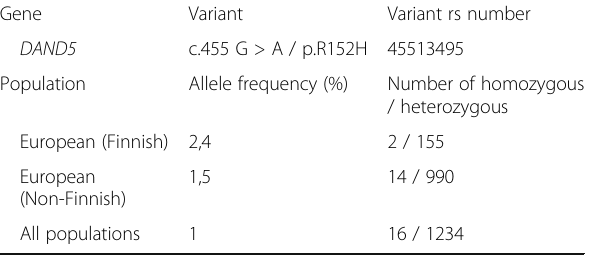
Table 3 DAND5 c.455 G > A allele frequency according to